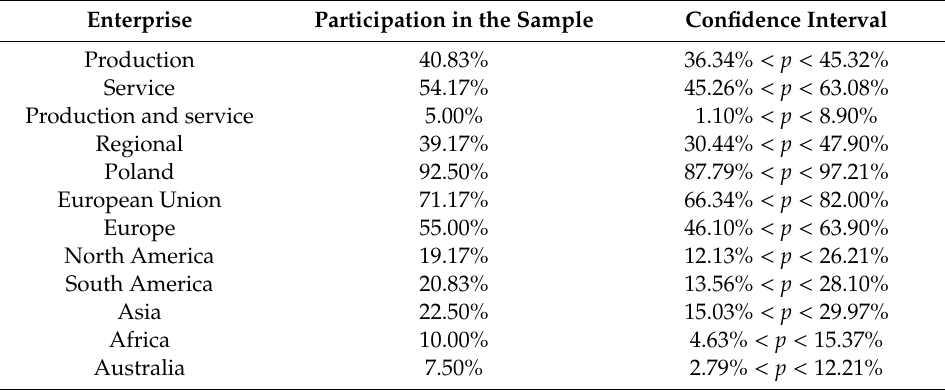
Table 2. Division of the surveyed